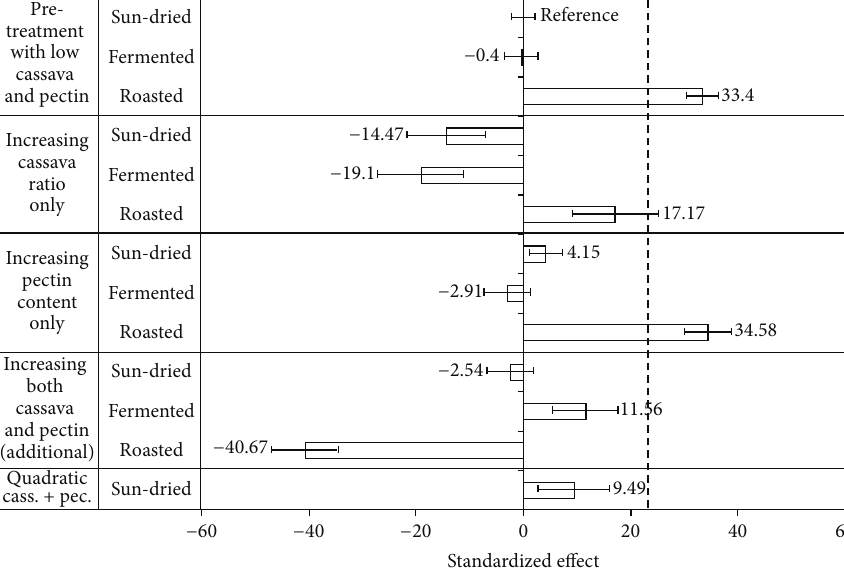
Figure 3: Modified Pareto chart showing the relative effects of pretreatments, flour composition factors, and the interaction of these on brownness according to the regression model ( 𝑅 2 = 0.93 ). Bread made with sun-dried flour with low cassava and low HM-pectin contents was set as reference bread. The brownness index of wheat bread is indicated by a dotted line. Effects with error bars not including point 0 are statistically significant at 95% confidence